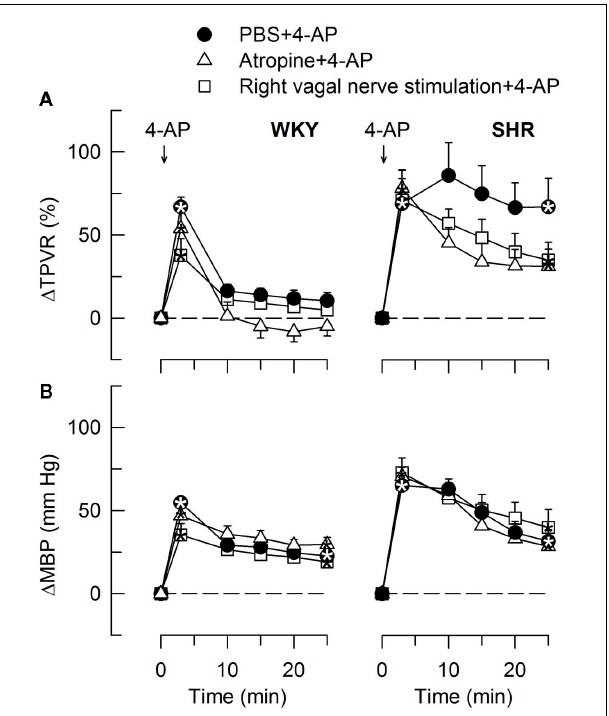
FIGURE 10 |TheTPVR- (A) and MBP- (B) response to 4-AP after pre-treatment with the peripherally restricted nAChR antagonist, ganglion blocker hexamethonium. Significant responses (* within symbol) during the initial response and after 25min, were detected as indicated. Significant group differences were not detected. Hexamethonium reduced baseline MBP in both strains and alsoTPVR in SHR ( Table 2 ). * – P ≤ 0.025.